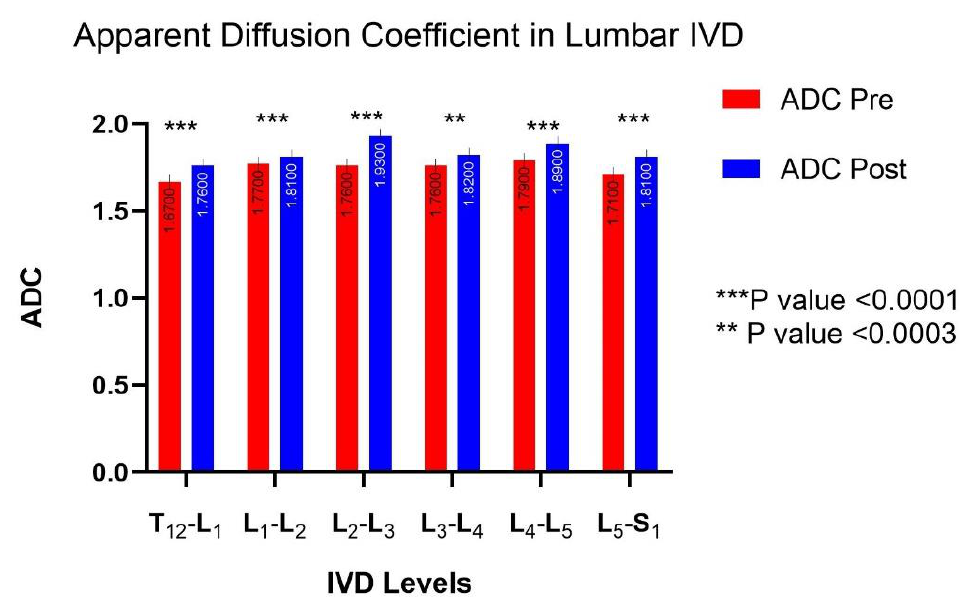
Figure 3. Apparent diffusion coefficient (ADC; value in ms ×10 −3 mm 2 /s) per intervertebral lumbar disc level (** p < 0.001; *** p < 0.0001). The ADC increased significantly after dry immersion, with an average increase of 7.34 ± 2.23% ( p < 0.05).